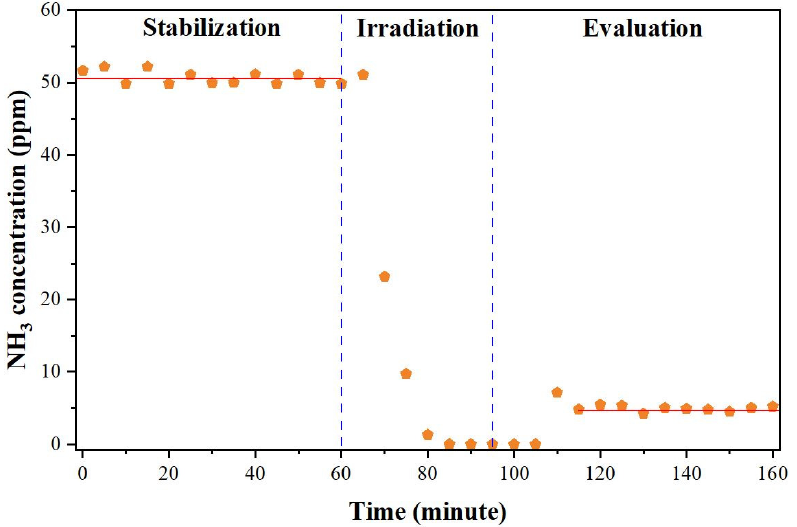
Figure 12. NH 3 gas removal capacity of the photocatalytic air purifier composed of 36 S,N-doped TiO 2 /Al 2 O 3 HF membranes in a test chamber without air circulation under a blue LED light source for 30 min (reactor #2).